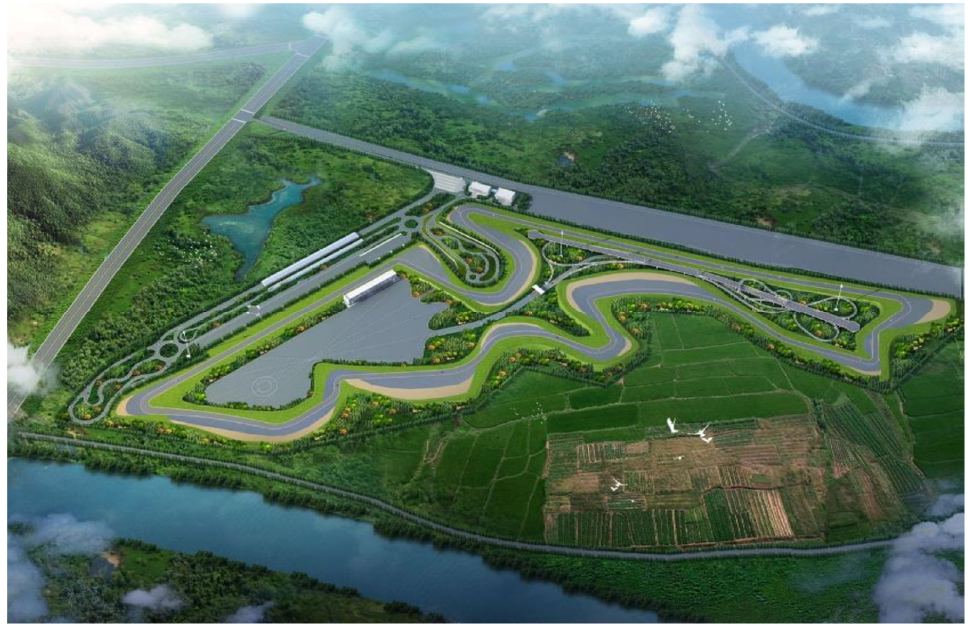
Figure 1. Plan view of the intelligent networked vehicle test site.